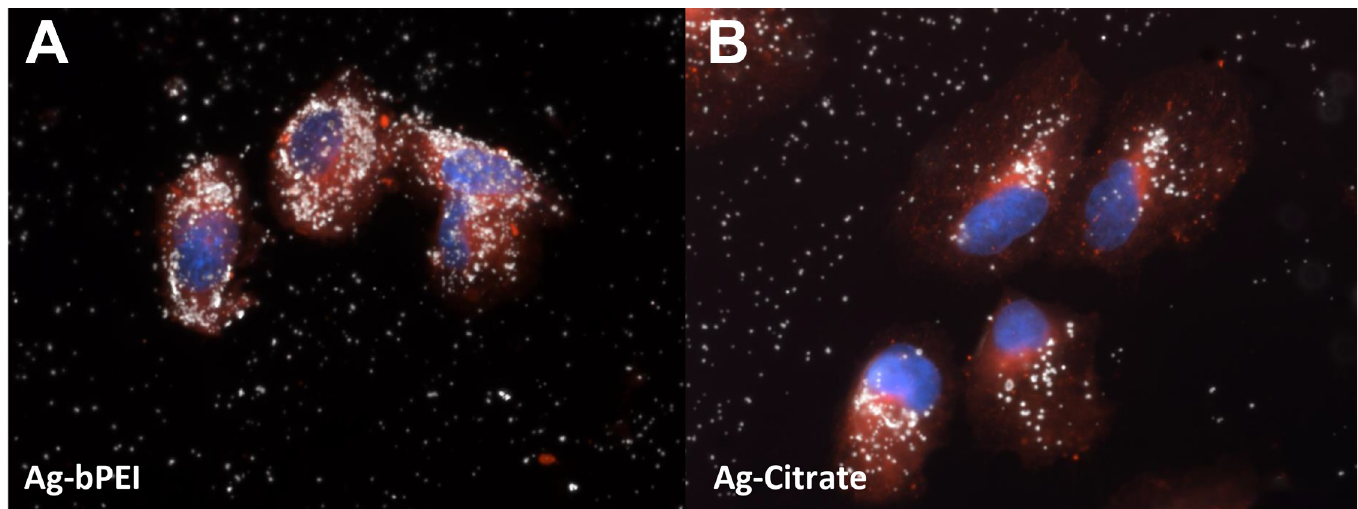
Fig 4. Microscopic observation of bPEI and citrate coated NP. Microscopic images of cells incubated with AgNP-bPEI (Fig 4A) and AgNP-CIT (Fig 4B) for 24 hours. The nuclei were stained with DAPI and the cytoplasm was stained with cell mask orange. The AgNP are represented by the white spots in the darkfield microscopy images. es. Magnification